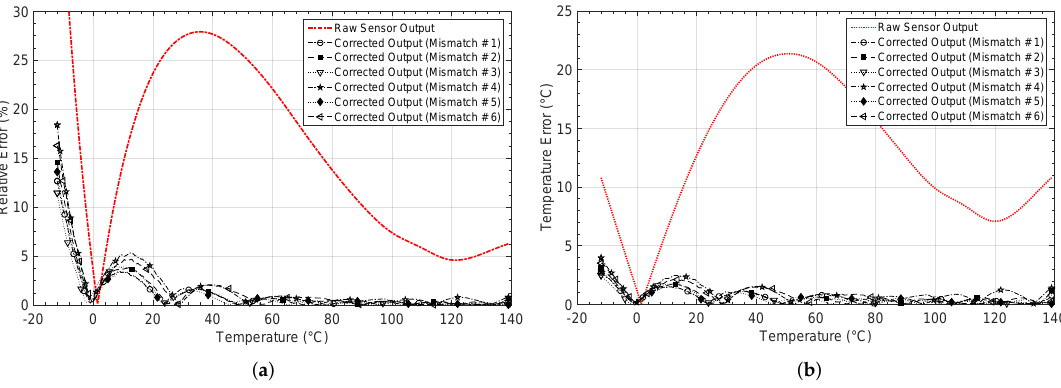
Figure 20. Thermistor output characteristic NL1 before and after correction by considering six mismatch cases between neurons.